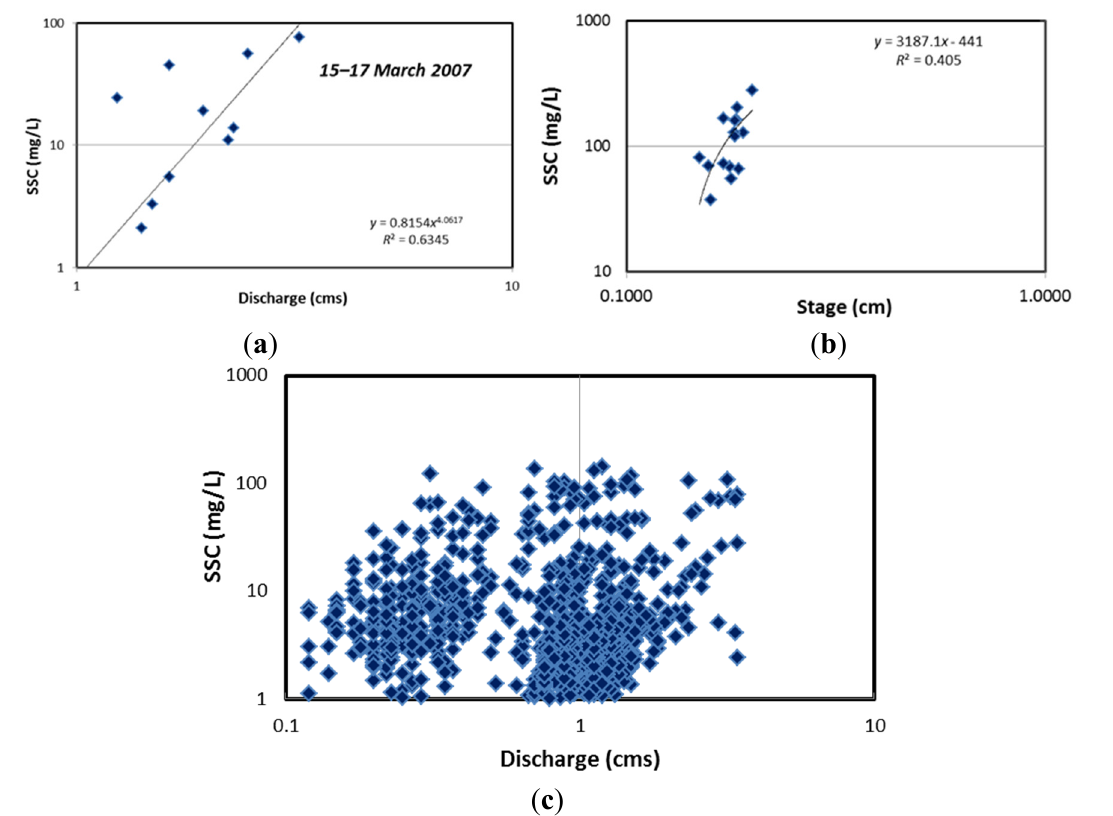
Figure 6. Statistically significant relationships were identified between SSC and discharge during individual events at the monitoring sites, such as shown for the Allen Creek #1 during an event in March 2007 ( a ); and at the Cherry Cove site during an 3–13 April 2010 event ( b ); Similar relationships do not exist when data are combined for multiple events at a site as shown for Allen Creek #2 ( c